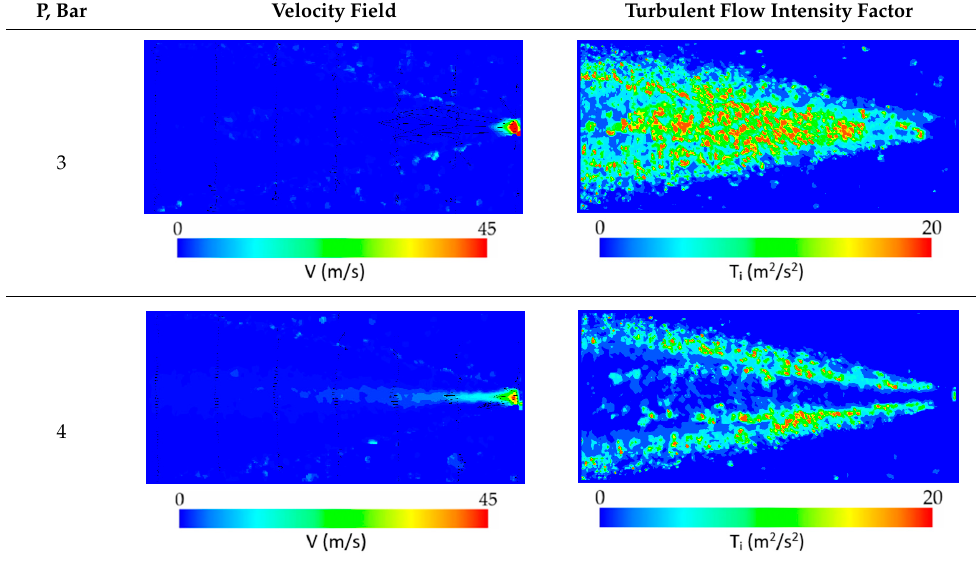
Table 2. Influence of pressure P supplying the nozzle on the character of velocity and turbulent flow intensity factor fields for stub regulation angle α = − 90°. P, Bar